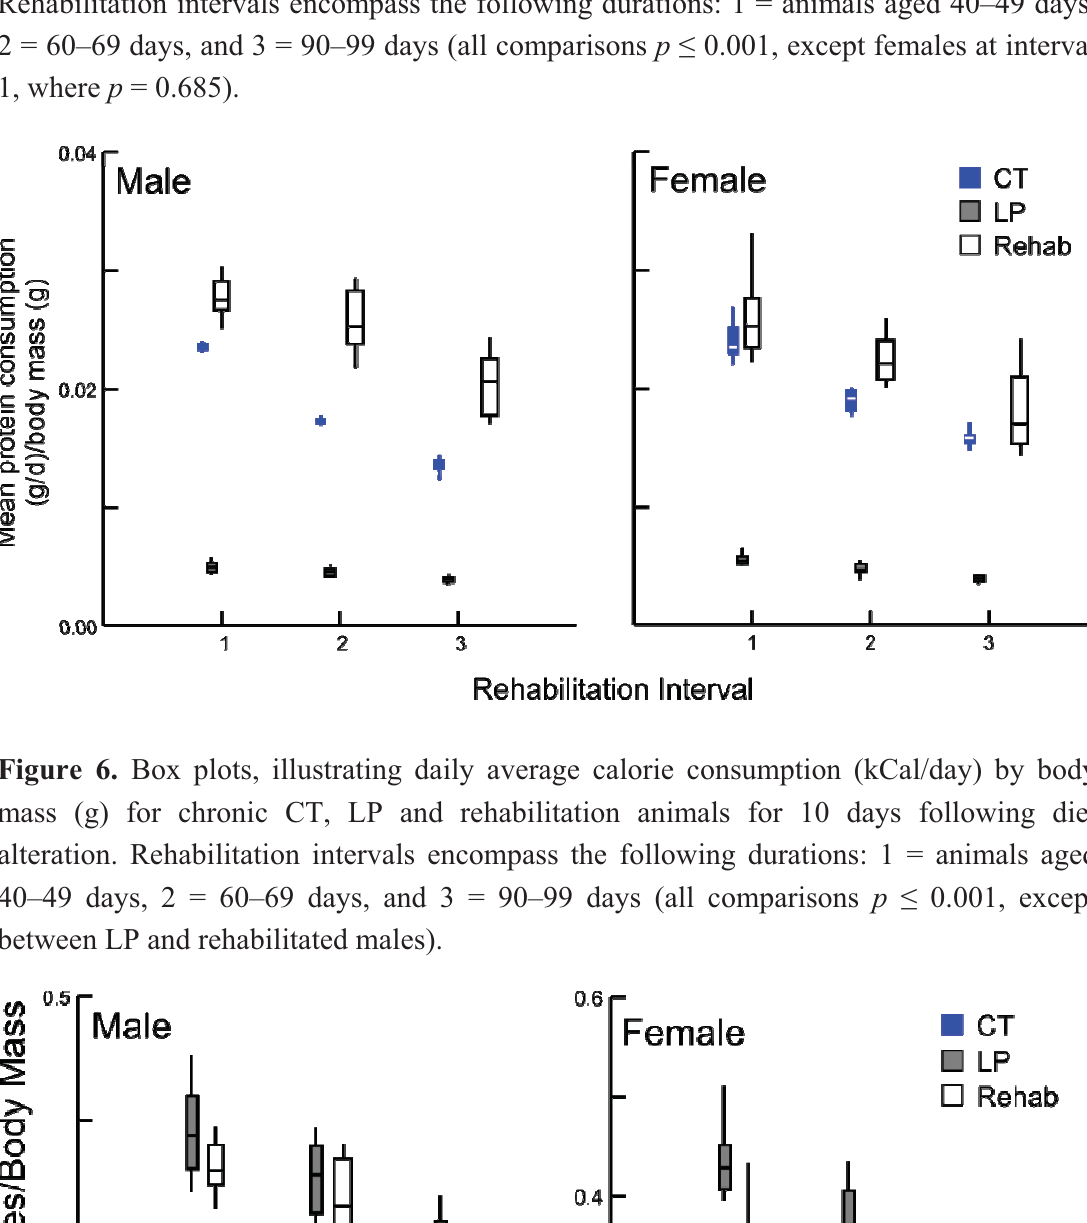
Figure 5. Box plots illustrating daily average protein consumption (g/day) by body mass (g) for chronic CT, LP and rehabilitation animals for 10 days following diet alteration.